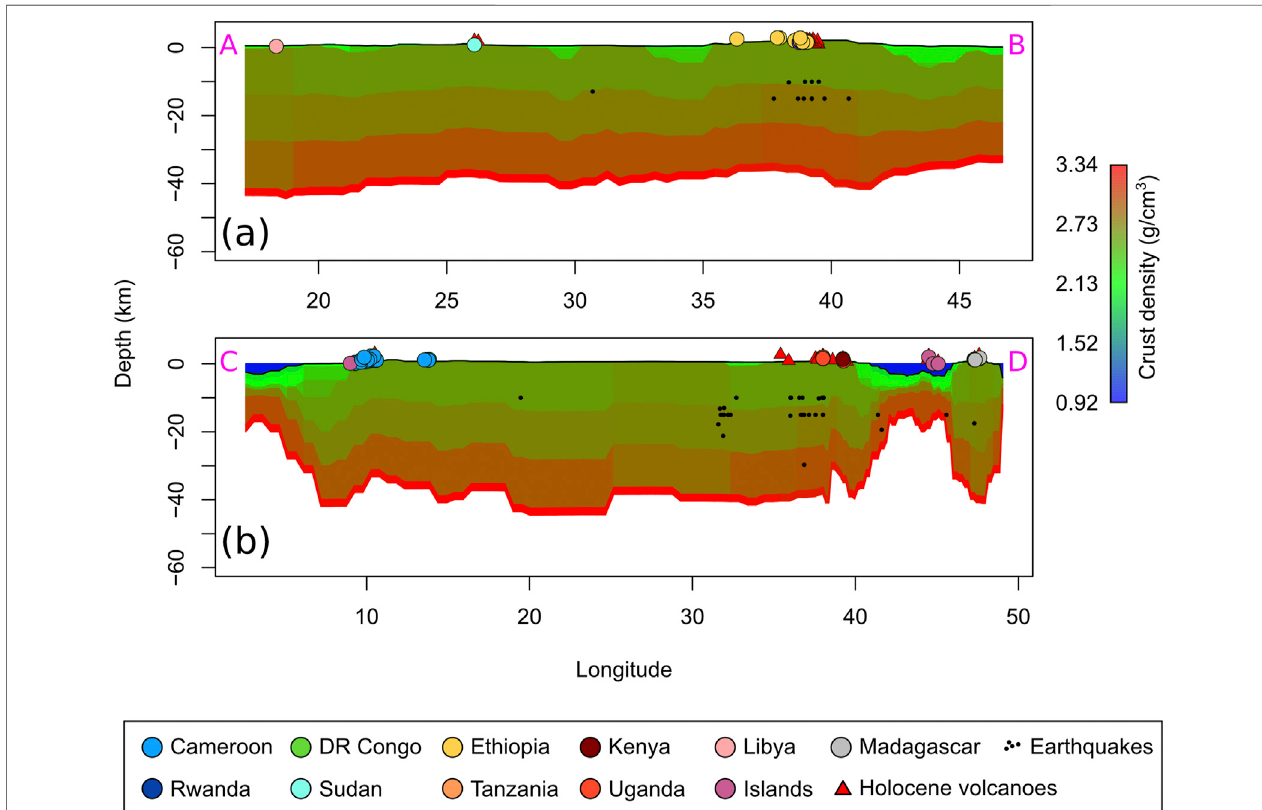
FIGURE 11 | Conceptual model to explain the abundant maar volcanism of the EAR and CVL, through a vertical section of the fi rst 40 – 50 km through the Earth ’ s crust (Laske et al., 2013). The transects A-B and C-D are traced in Figure 1 . Holocene active volcanoes are exported from the Global Volcanism Program-Smithsonian database